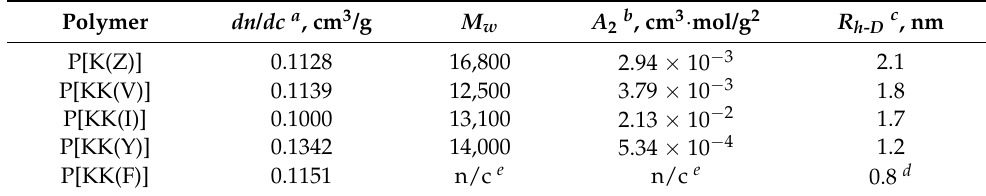
Table 1. Molecular-weight and hydrodynamic characteristics of synthesized poly- L -lysine and its derivatives obtained by modification with hydrophobic amino acids determined by SLS (DMF, 25 ◦ C).